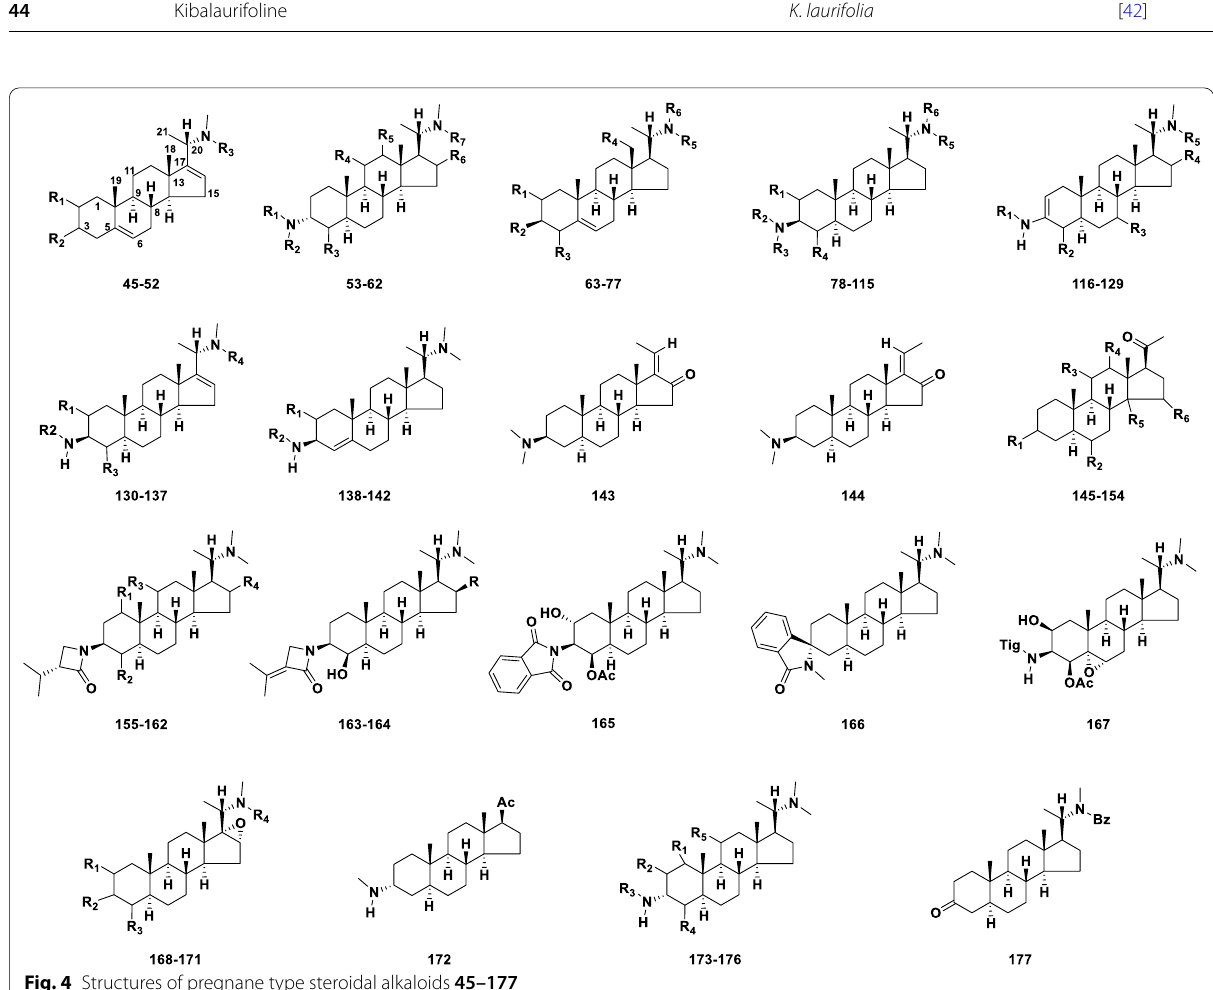
Fig. 4 Structures of pregnane type steroidal alkaloids